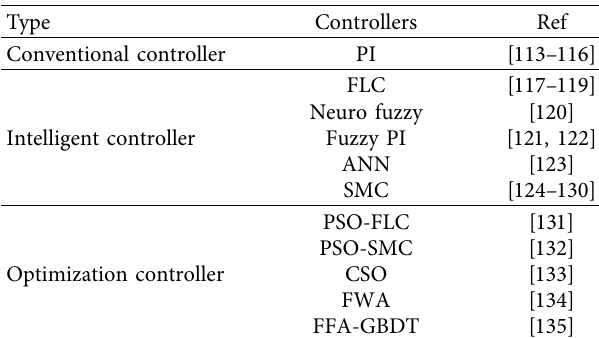
Table 2: Literature of different controllers in EVs.